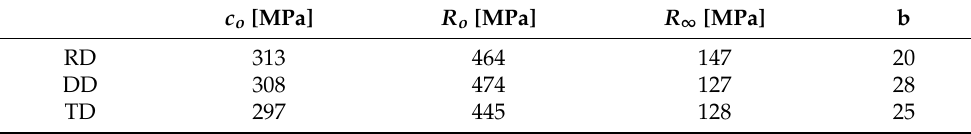
Figure 4. ( a ) Experimental and ( b ) numerically predicted true stress–true plastic strain curves. For RD, DD and TD, the respective material parameters are shown in Table 2, leading to good agreement of the numerically predicted stress–plastic strain curves (Sim) with the experimental data (Exp) shown in Figure 4b. Deviations can only be seen at the end of the loading process ( (cid:101) pl = 0.15) after the onset of necking, leading to local three-dimensional stress states, as well as caused by damage processes that cannot be simulated by the elastic–plastic model. Table 2. Plastic material